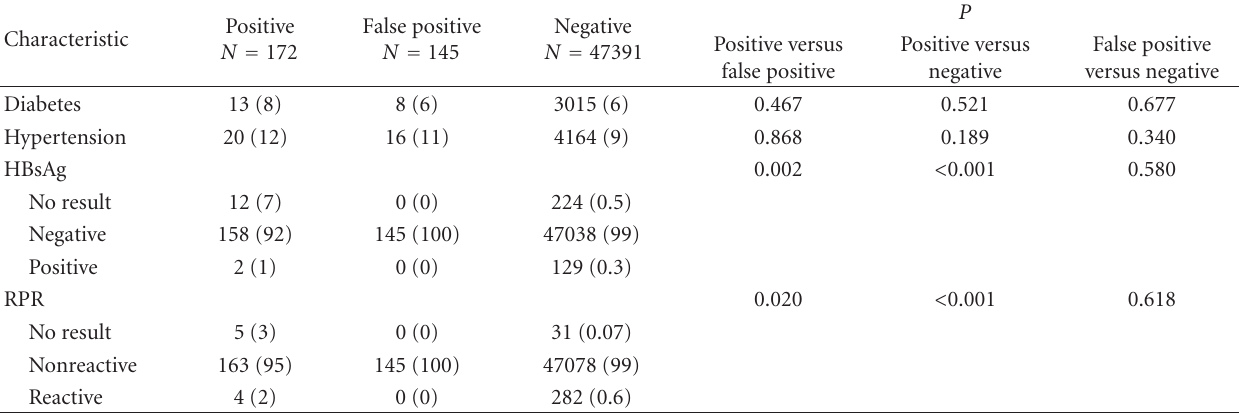
Table 2: Comorbidities, hepatitis B, and RPR results in HIV positive, false positive, and negative women.